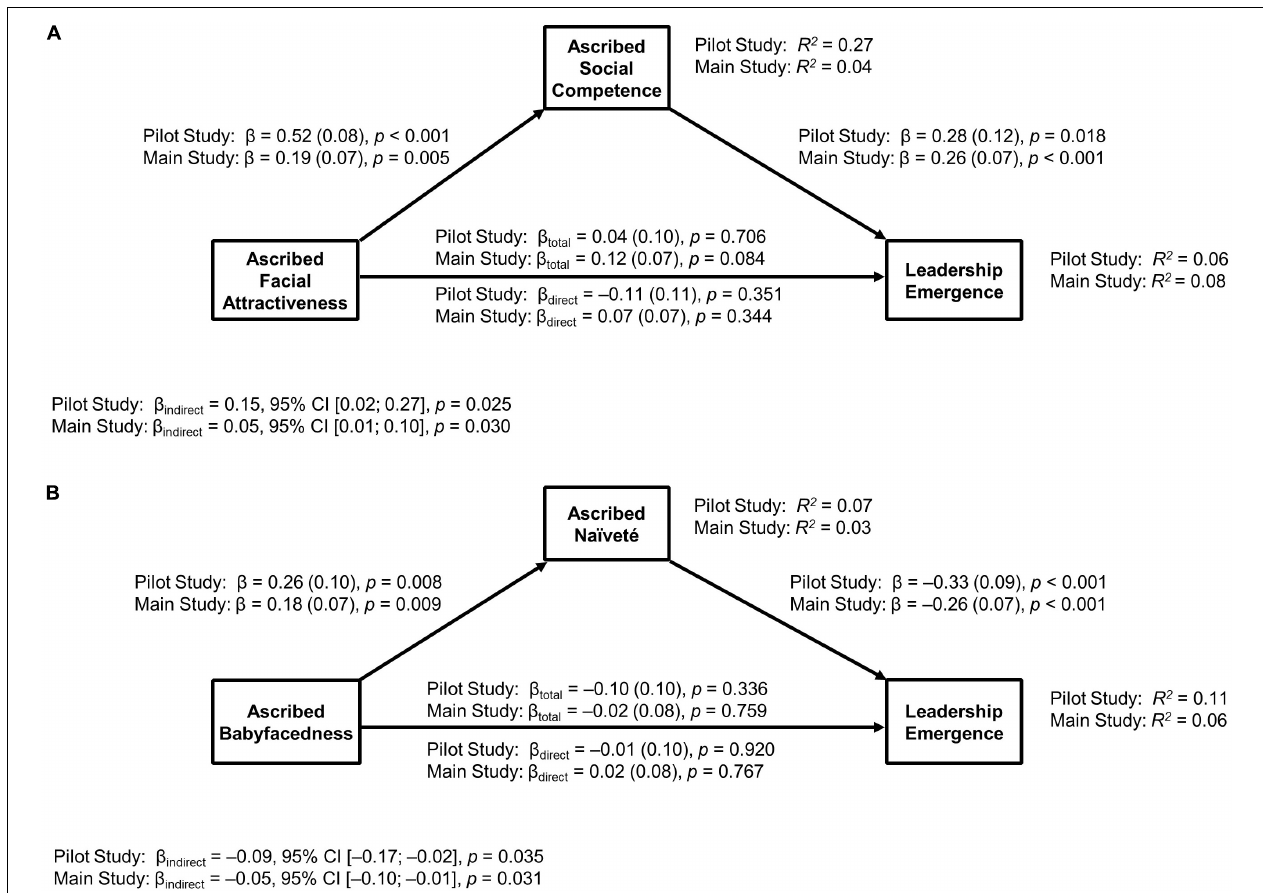
FIGURE 2 | β (standard error) values represent standardized regression coefficients. total = total effect. direct = direct effect. R 2 = variance explained by the model. Results from the pilot study as well as from the main study revealed significant indirect effects for both paths, ascribed attractiveness – social competence –